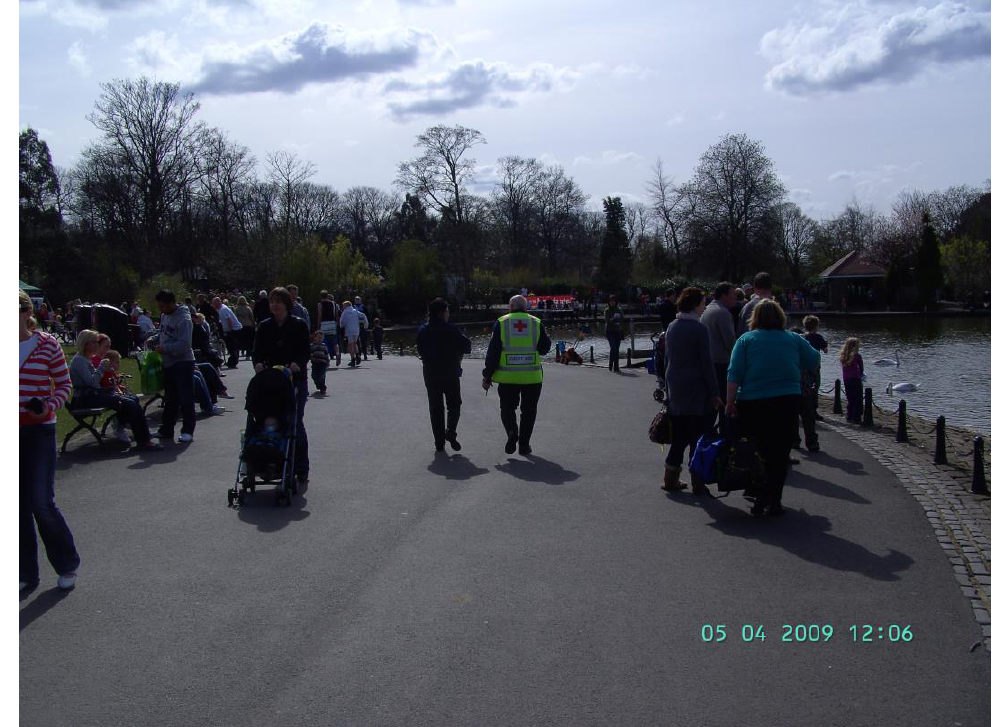
Figure 2. The Sunday of the Spring Saltwell Park Show weekend, 2009.